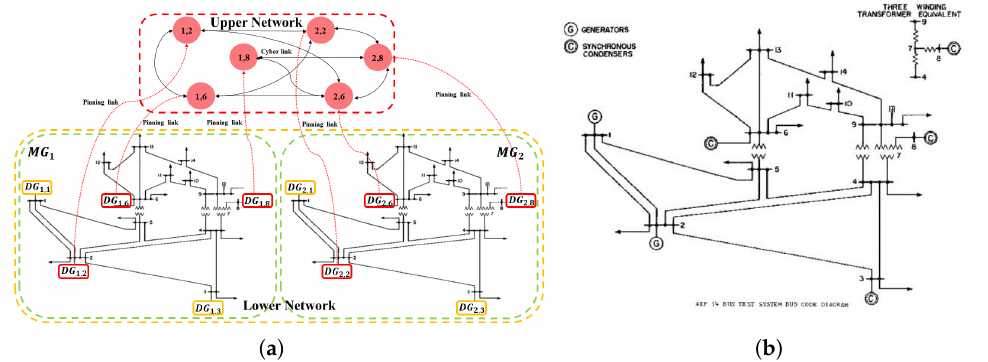
Figure 2. Multiple MicroGrids Modeling (MMGs) system composed of two identical IEEE14-bus Test systems: ( a ) Two-layer network: intra-cluster lower network shown by the yellow dotted line and the inter-cluster upper network shown by the red dotted line; ( b ) Single IEEE 14-bus test system. Table 1. Two IEEE 14-bus test systems MMGs system: parameters values. Initial Conditions for the Multiple MG Cluster System Voltage magnitude of generator bus ∀ k = 1,2 [ p . u .